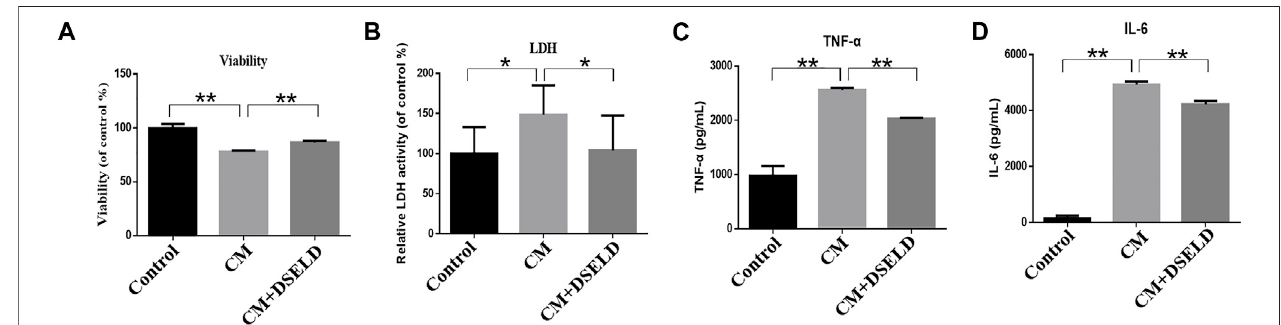
FIGURE 4 | Dangshen Erling decoction (DSELD) inhibits conditioned media (CM)-induced in fl ammation in the H9C2 cells. (A) H9C2 cell viability was evaluated by MTTassay24hafterincubationwithCM. (B – D) Theelevationoflactatedehydrogenase(LDH),tumornecrosisfactor(TNF)- α ,andinterleukin(IL)-6fromdifferentgroups. *p < 0.05, **p < 0.01.